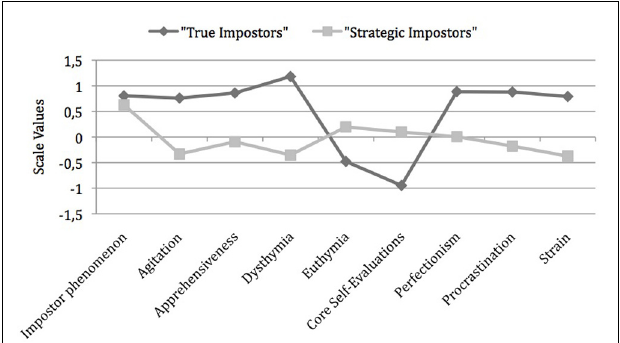
FIGURE 4 | Cluster solution based on Ward procedure after optimization with k -means algorithm ( n =